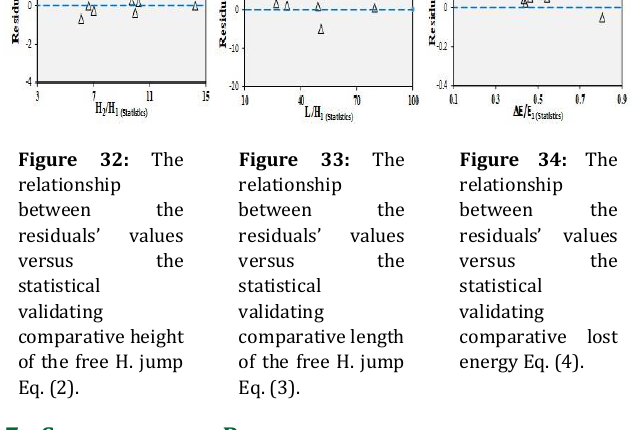
Figure 29: The relationship between the validating values of the comparative height of the free H. jump Eq. (2) and the experimental measurements.